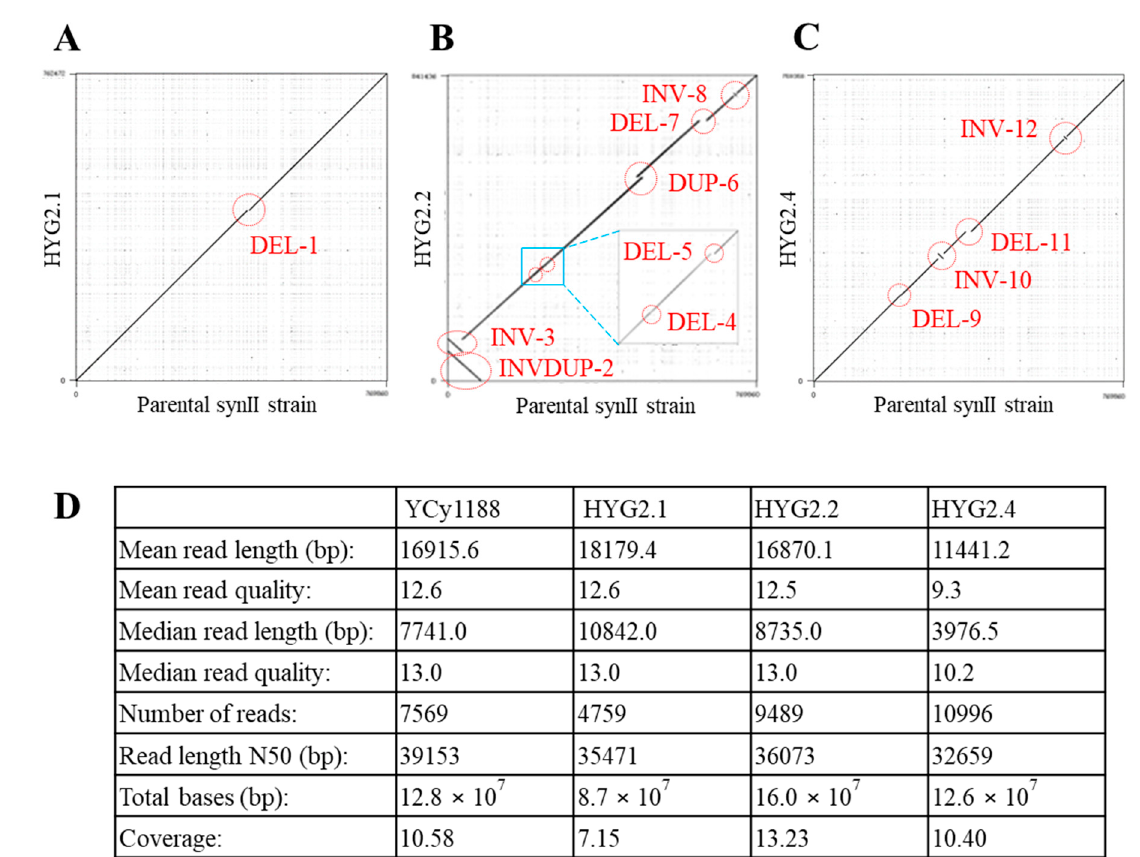
Figure 3. Dot plots illustrating the structural variations observed in the SCRaMbLEd strains HYG2.1 ( A ), HYG2.2 ( B ) and HYG2.4 ( C ) via nanopore sequencing. Each SCRaMbLEd strain (y-axis) is plotted against the parental synII (YCy1188) strain (x-axis) and each structural variation can be referenced to Supplementary Table S1. ( D ) Nanopore sequencing run data. Strain HYG2.2 (YCy2935) and HYG2.4 (YCy2937) showed more complex